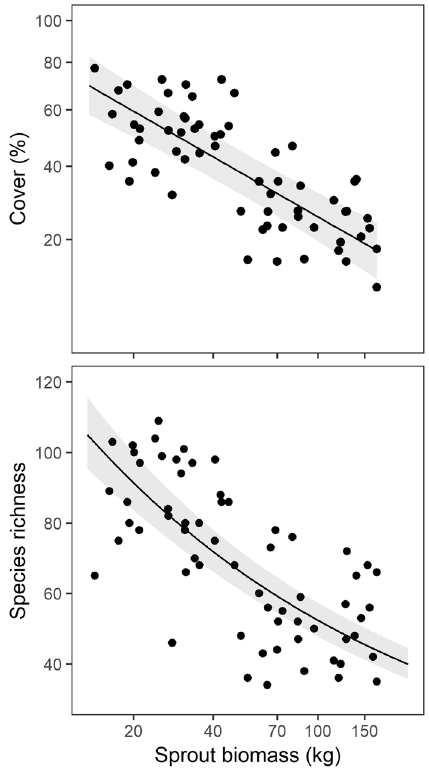
Figure 2. Effects of sprout biomass on species richness and cover of herbaceous vegetation in the period of significant influence (from 2nd VS to 4 th VS after logging). Solid lines within the grey bands represent a fitted linear mixed-effects models with 95% confidence intervals.